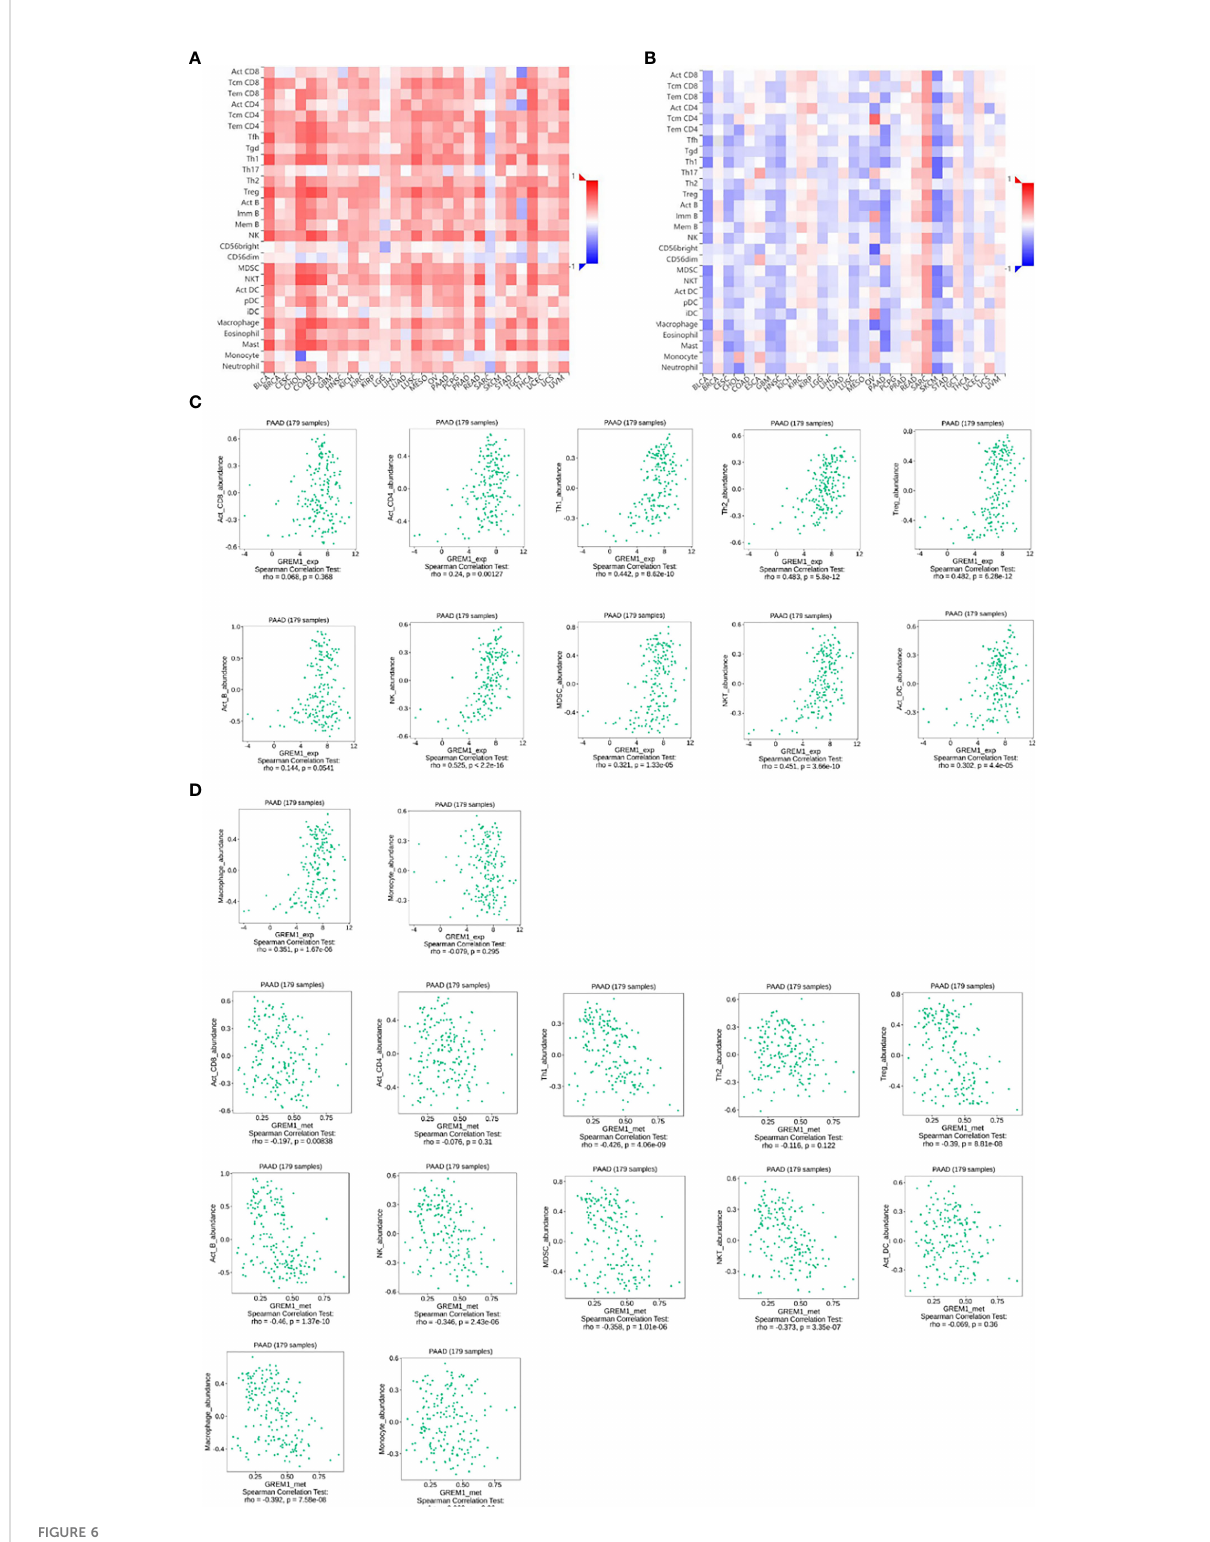
FIGURE 6 GREM1 overexpression regulates immune cell in fi ltration of PDAC. (A) Heatmap of immune cell in fi ltration in PDAC via TISID database. (B) Heatmap of immune cell in fi ltration in PDAC after GREM1 methylation. (C) Scatterplots of the correlations between GREM1 expression and immune cell in fi ltration and (D) GREM1 methylation and immune cell in fi ltration. PDAC, pancreatic ductal